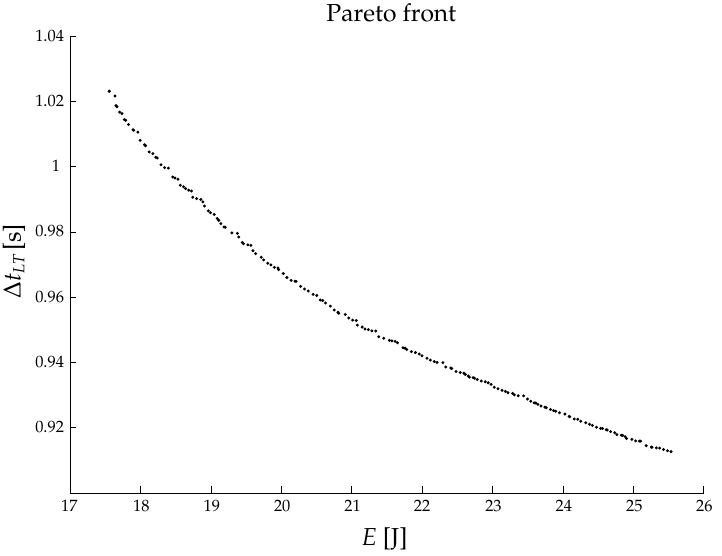
Figure 3. Pareto front for the two objectives E and ∆ t LT .